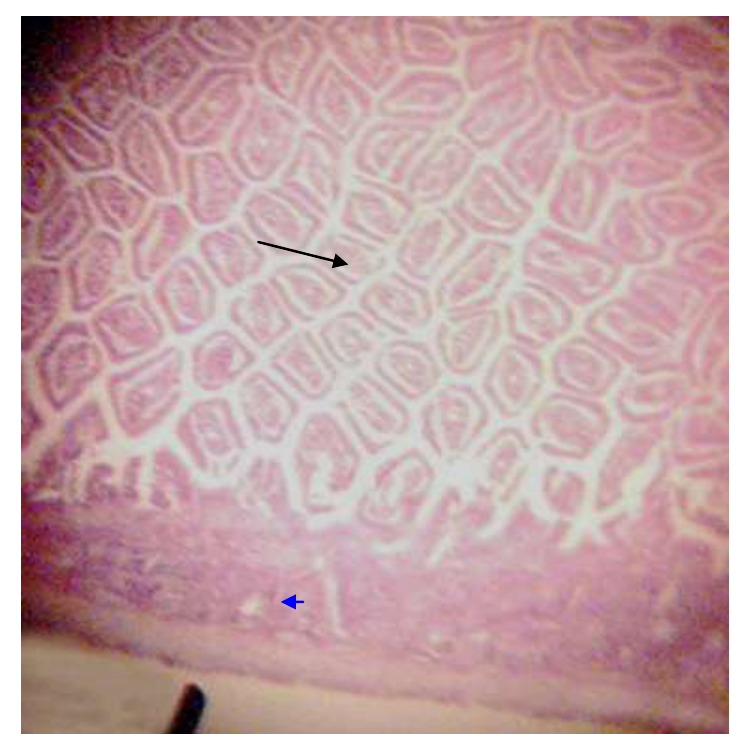
Figure (3) histological section of the intestine notices the hyperplasia, hypertrophy of the mucosa ( ) with edema in the sub mucosa ( ). (H and E